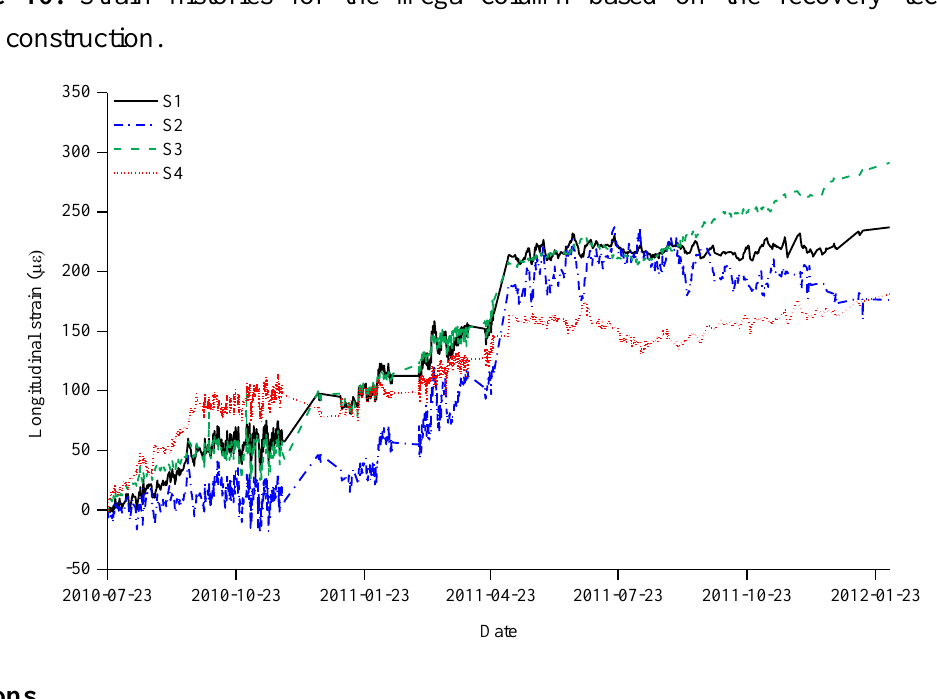
Figure 10. Strain histories for the mega column based on the recovery technique during